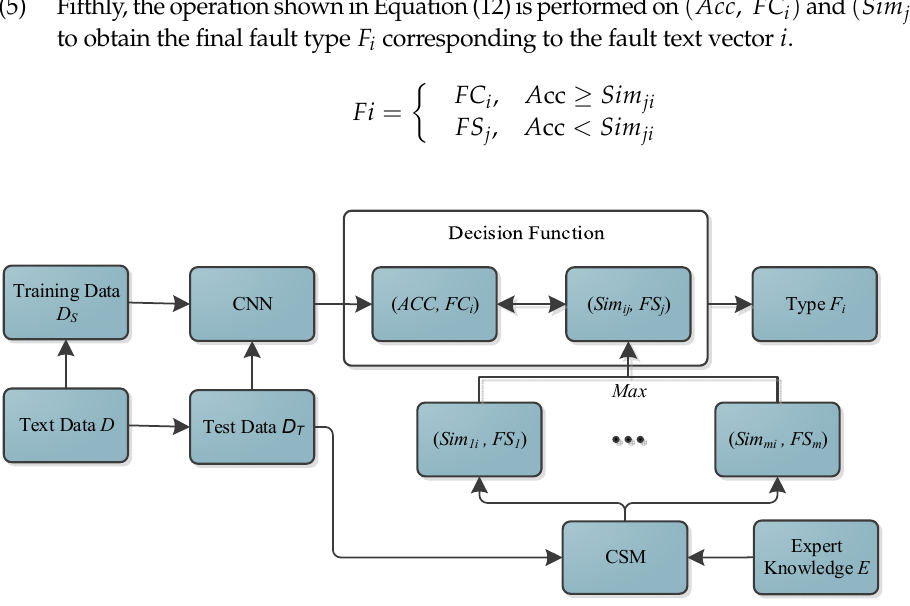
Figure 4. The prior-knowledge CNN model structure.